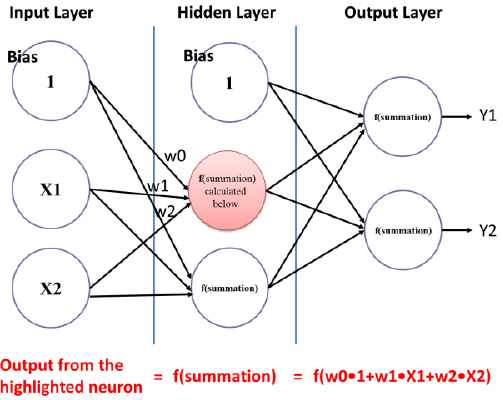
Figure 2. A simple structure of a multilayer perceptron (MLP) with a hidden layer.